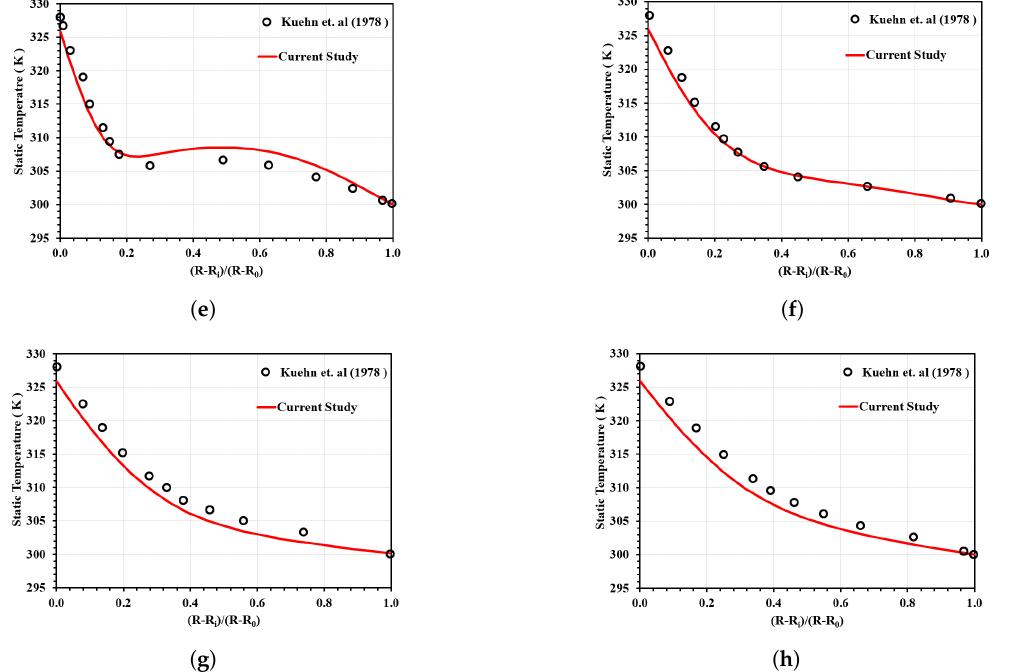
Figure 4. Numerical solutions for the SST k − ω with the buoyancy effect, compared with measure- ments from previous experiments: ( a ) Static temperature contour; ( b ) θ = 0 ◦ ; ( c ) θ = 30 ◦ ; ( d ) θ = 60 ◦ ; ( e ) θ = 90 ◦ ; ( f ) θ = 120 ◦ ; ( g ) θ = 150 ◦ ; and ( h ) θ = 180 ◦